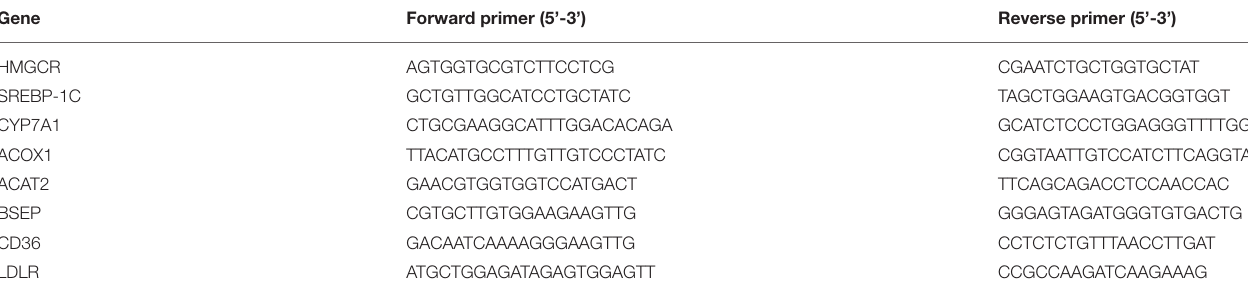
TABLE 1 | Primer sequences for quantitative real-time PCR.